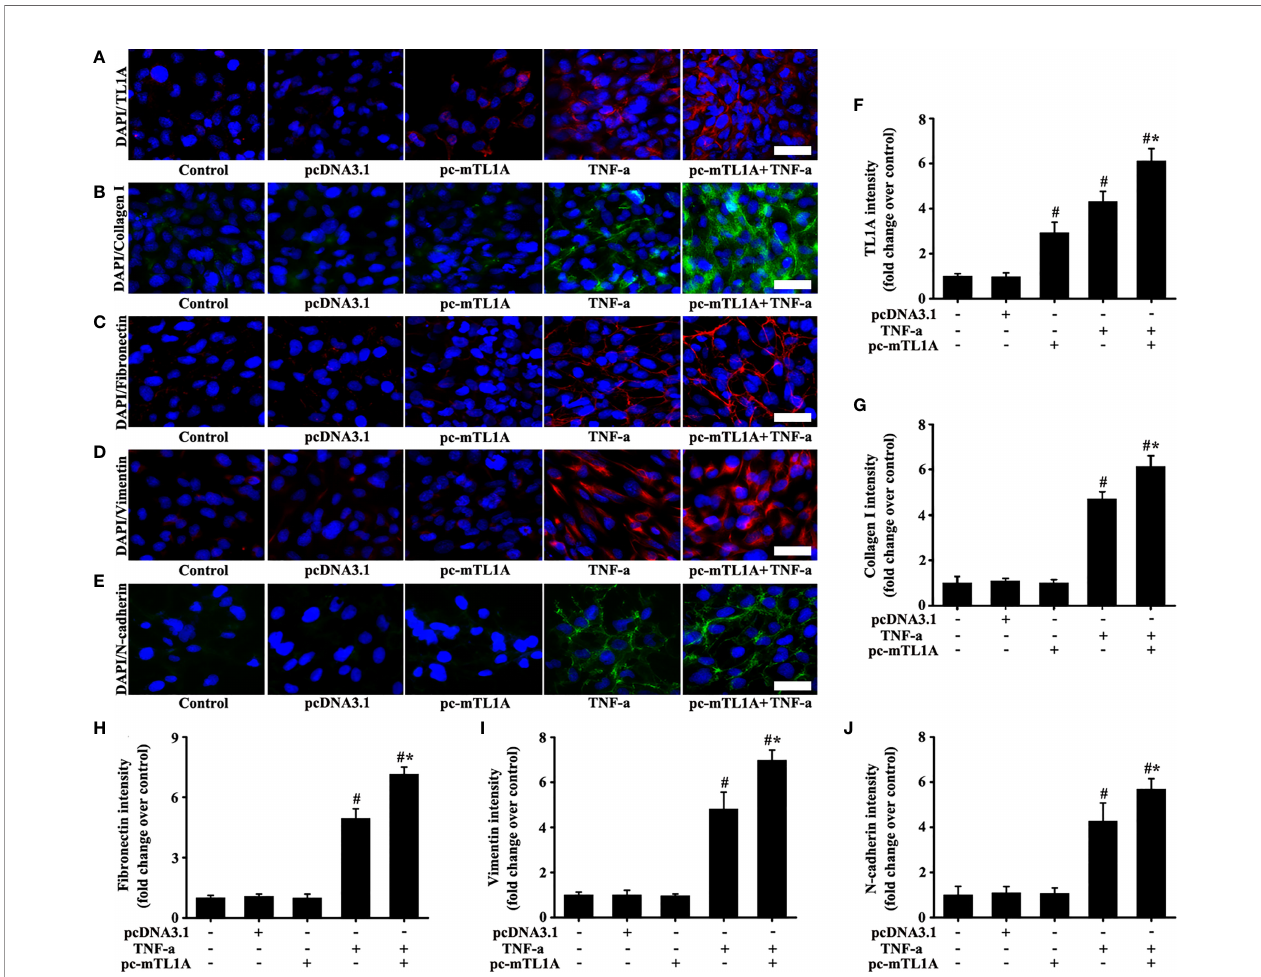
FIGURE 9 | Effects of TL1A overexpression by pc-mTL1A on the EMT formation in Beas-2B cells. TNF-a (50 ng/mL) stimulation for 48 h as the best cell model based on the experimental results. The levels of TL1A ( A , red), collagen I ( B , green), fi bronectin ( C , red), vimentin ( D , red), and N-cadherin ( E , green) were detected by immuno fl uorescence. (A – E) : magni fi cation 200 ×, scale bar 50 µm. (F – J) intensity analysis of (A – E) , respectively. Data are expressed as the means ± SD for three independent experiments. # p < 0.05 versus the control group. # *p < 0.05 versus the TNF-a